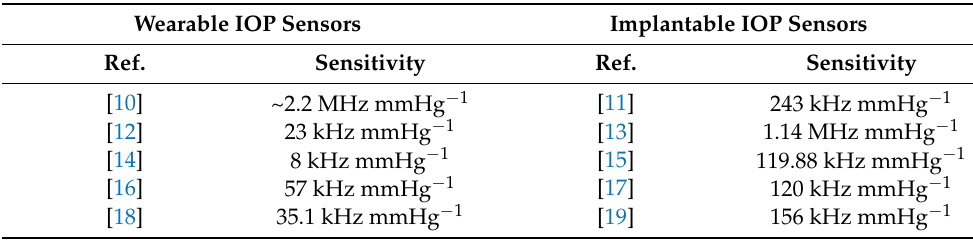
Table 1. Comparison of the sensitivity of inductive couple telemetry − based wearable IOP sensors and implantable IOP